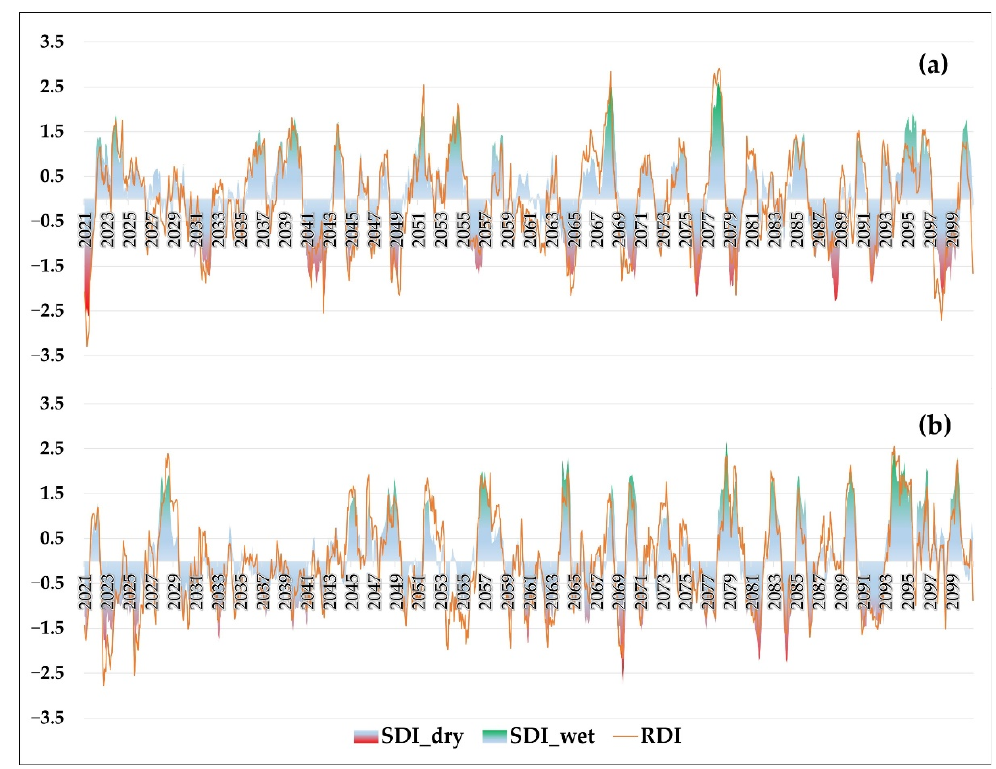
Figure 15. The Minija River, accumulation period 12 months: ( a ) RCP 4.5; ( b ) RCP 8.5.